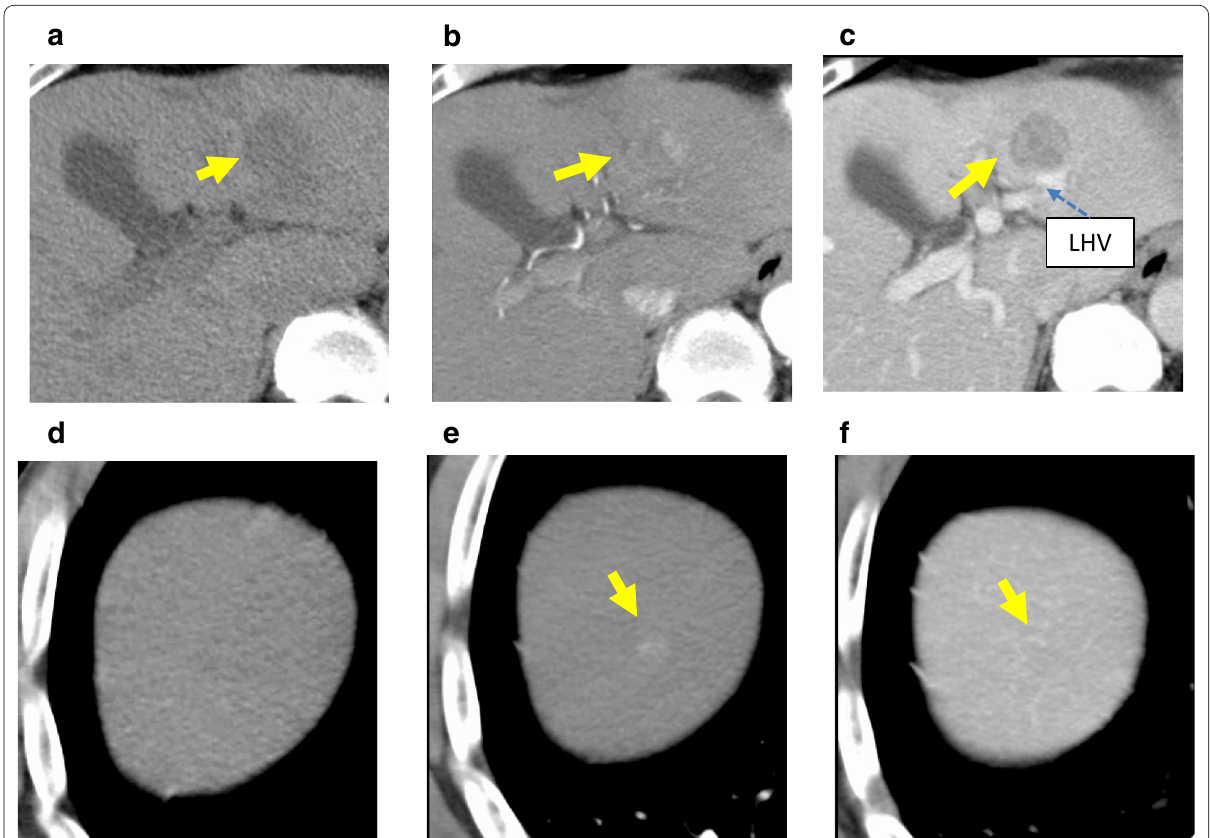
Fig. 1 Contrast‑enhanced computed tomography (CT) revealed the presence of lesions in the patient’s liver. a A low‑density mass, 24 mm in size, in segment III on plain CT. b Enhancement of the lesion in the early phase was noted. c In the late phase, washout was observed. The tumor was in contact with the left hepatic vein (LHV). d The tumor in segment VIII was not clear on plain CT. e An 8‑mm tumor was also present in segment VIII of the liver showing contrast enhancement. f Washout was noted in the delayed